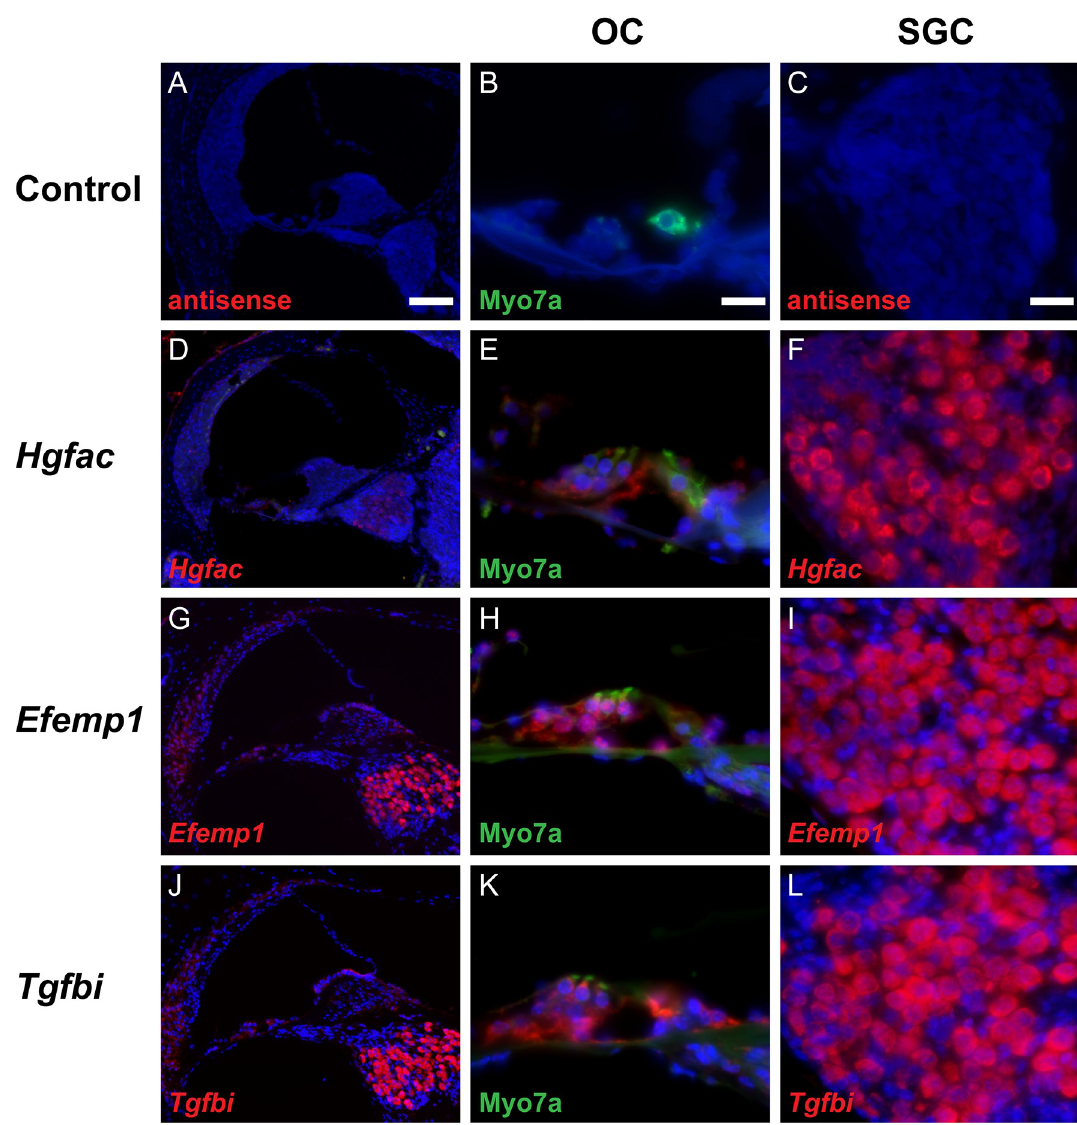
Fig 5. Fluorescence in situ hybridization (FISH) of Hgfac , Efemp1 , Tgfbi genes in murine cochlear cross sections. ( A-C ) Negative controls for each target gene, hybridized with corresponding antisense probes, revealed no signal. ( D, G, J ) Hgfac , Efemp1 and Tgfbi were all localized in the organ of Corti and spiral ganglion, while Efemp1 and Tgfbi were also found in the spiral ligament ( E, H, K ). A magnified view of the organ of Corti revealed that Hgfac , Efemp1 , and Tgfbi RNA probes hybridized with IHCs, OHCs and adjacent supporting cells. SGNs were intensely hybridized with Efemp1 and Tgfbi RNA probes ( I, L ), while the signal from Hgfac RNA probe was much weaker in the spiral ganglion ( F ). Myosin VIIa was used as a marker of hair cells (green) along with the marker of nuclei, DAPI (blue). Scale bars, 100 μ m in the first column; 20 μ m in the second and third columns.